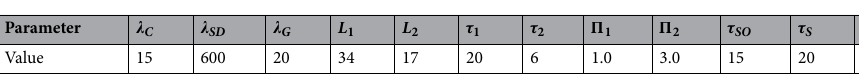
Table 2. The specific parameter values of the experiment.